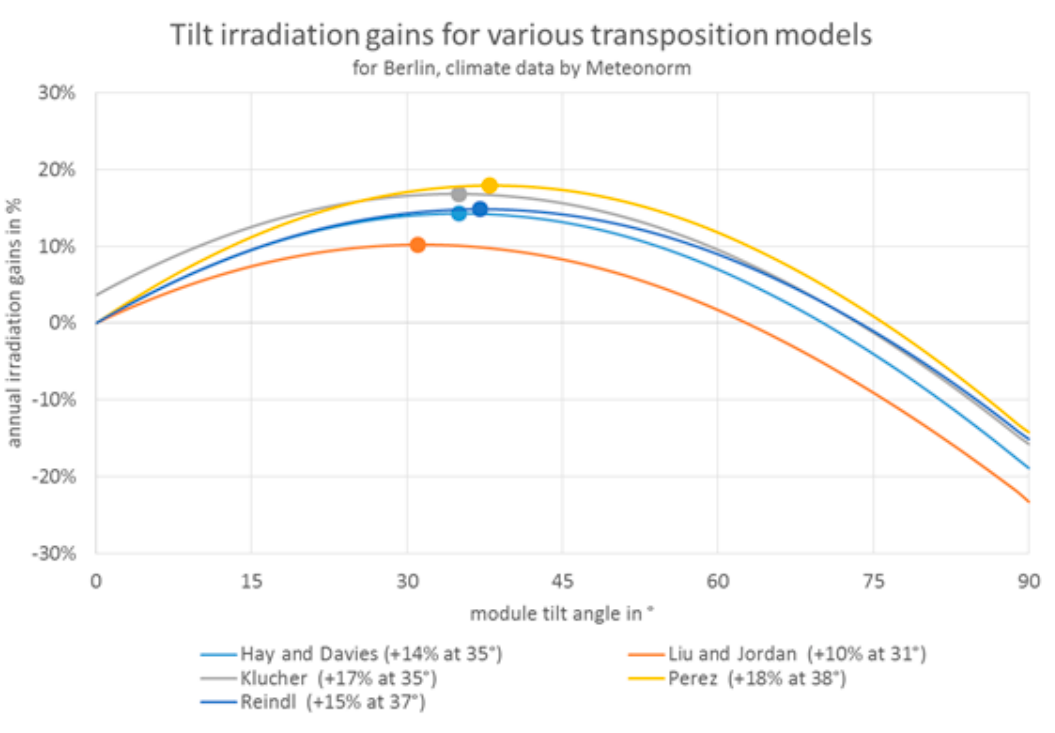
Figure 5. Annual tilt irradiation gains for various transposition models, calculated for Berlin, Germany, with one-hour climate data from Meteonorm [40]. The optimum tilt angles calculated by the models lie in the range from 31 ◦ to 38 ◦ . The Liu and Jordan model [23] produces the lowest irradiance gains while the model by Perez [25] produces the highest gains for tilt angles higher than 28 ◦ . Remarkably, the Klucher models [24] produces an irradiation gain of >0% for horizontal modules. It also produces highest gains for tilt angles up to 28 ◦ .